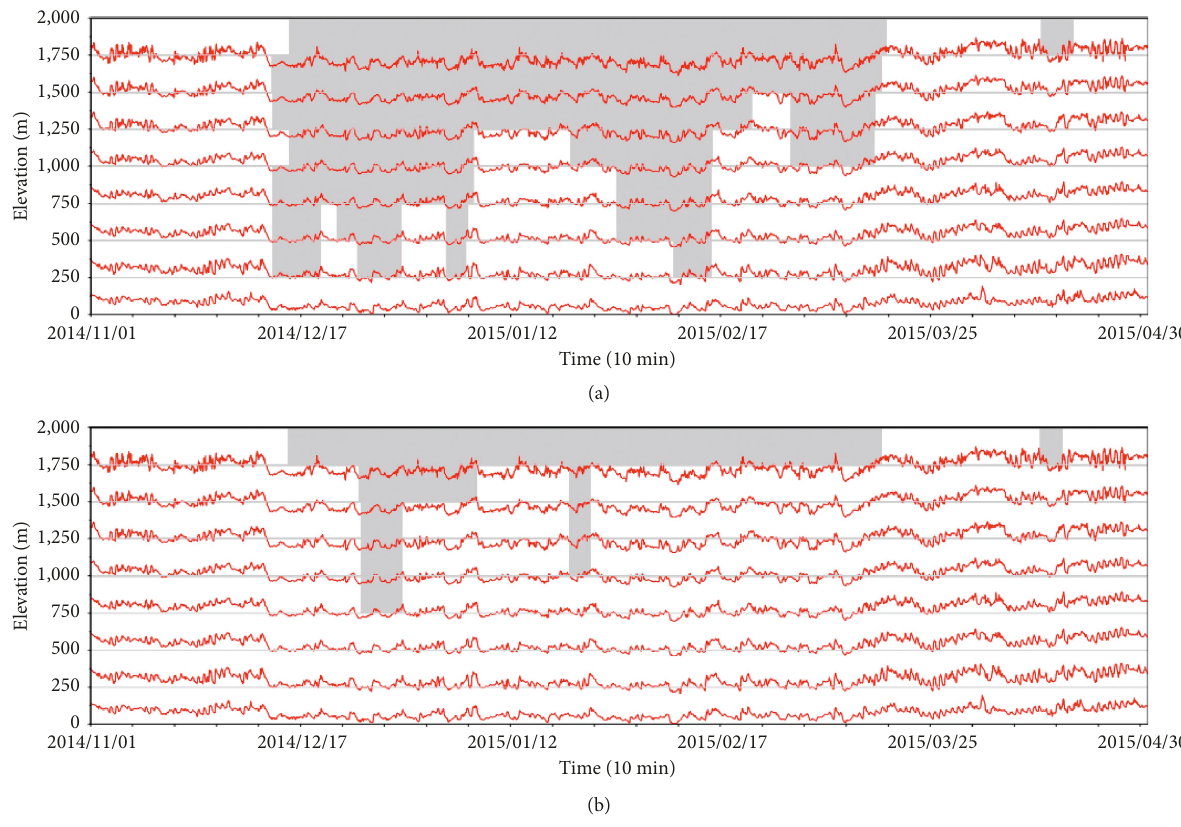
Figure 12: Change of the snowline (shaded area) over Jeju Island from November 1, 2014, to April 30, 2015, determined by applying the variable threshold method ((a) snow coverage 10% or higher; (b) snow coverage 90% or higher). Also, the thin wiggly line represents the air temperature measured at each elevation, which is moving around the reference temperature 0 ° C (i.e., the horizontal line at each